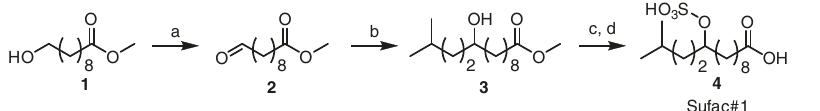
Fig. 5 Overview of synthesis of sufac#1. Reagents and conditions: a PCC, DCM, 0 °C; b Mg, THF, argon; c SO 3 /pyridine complex, pyridine; d NaOH, H 2 O